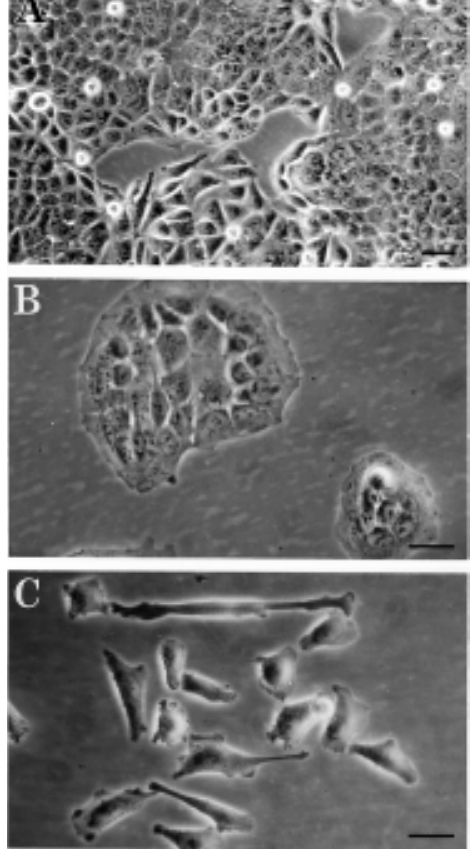
Figure 1. Phase contrast images of monolayer cultures of the LISP-I cell line and its cell clones: LISP-I (A); LISP-A10 (B), and LISP-E11 (C). Bars: 50